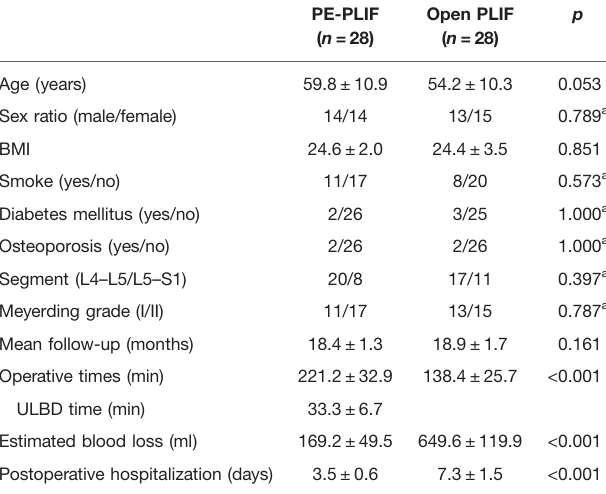
TABLE l | Comparison of demographic data and perioperative